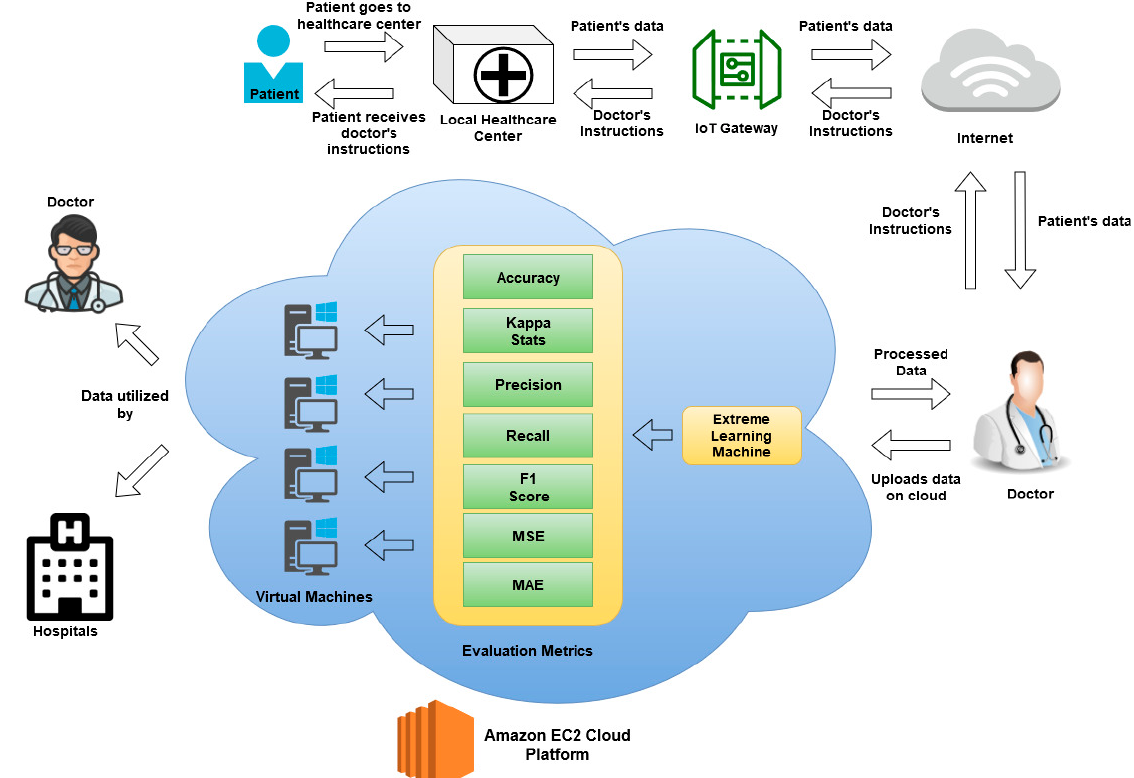
Figure 1. Components of the proposed architecture.